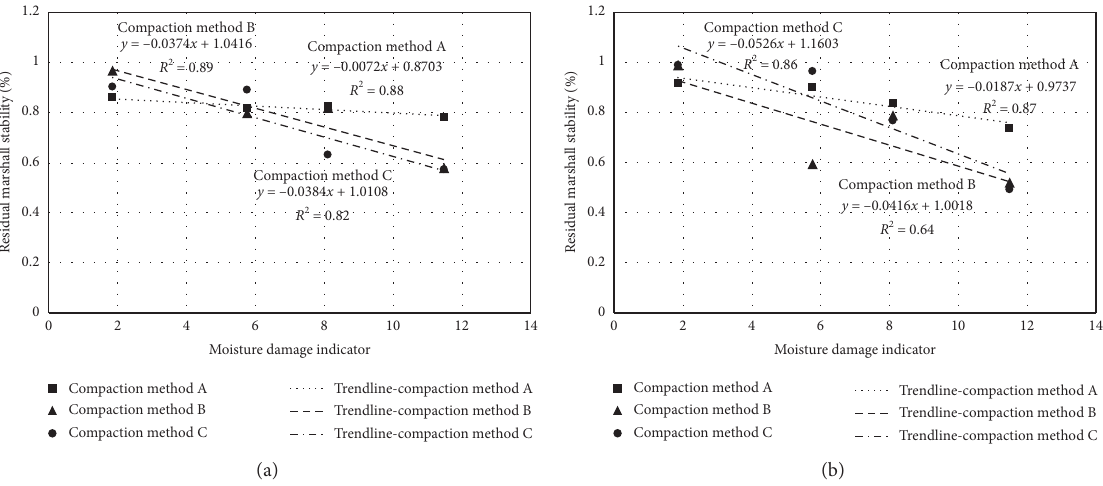
Figure 8: Correlation between RMS and moisture damage indicator for (a) short- and (b) long-term